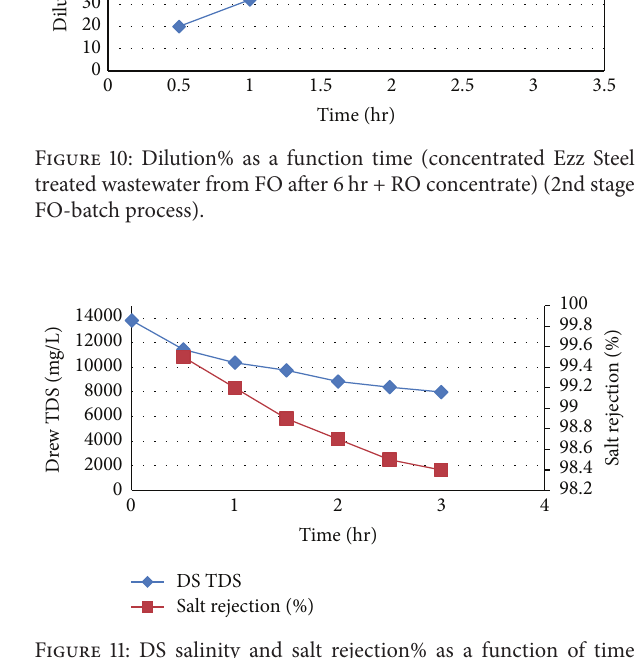
Figure 11: DS salinity and salt rejection% as a function of time (concentrated Ezz Steel treated wastewater from FO after 6hr + RO concentrate) (2nd stage of FO-batch